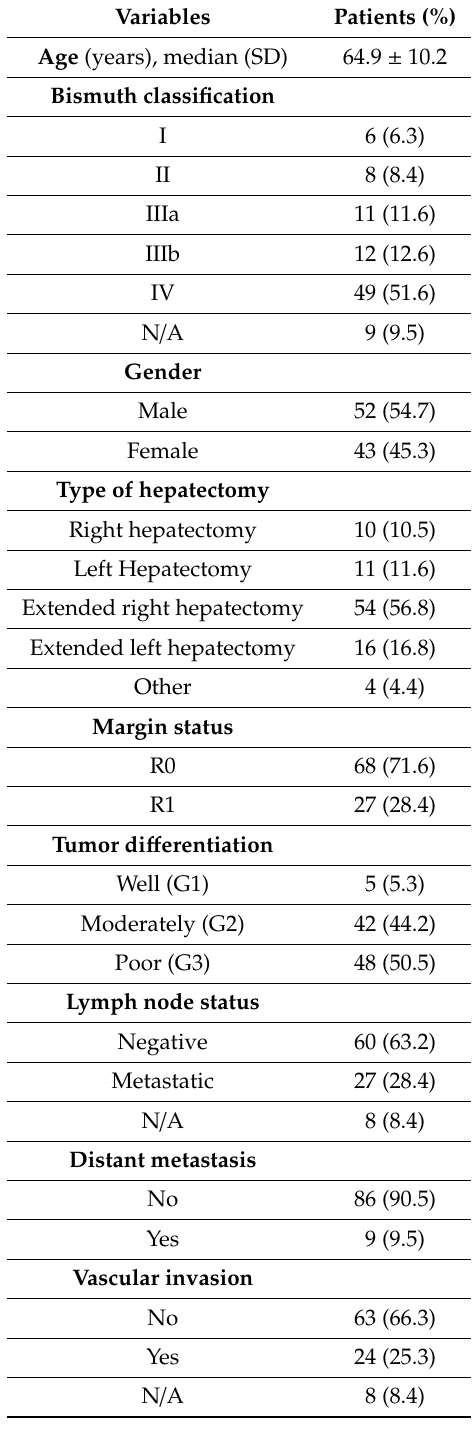
Table 2. Demographic and clinicopathologic characteristics of 95 patients with resected perihilar cholangiocarcinoma. IQR: interquartile